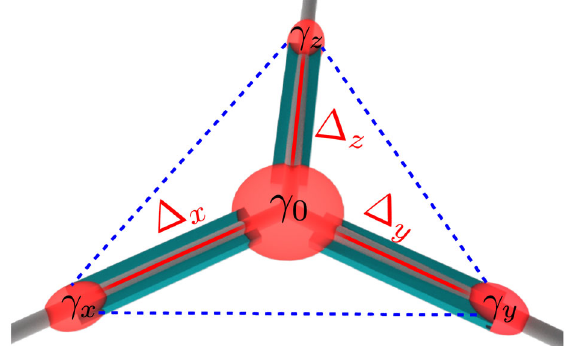
FIG. 1. The Y -junction system. Lines and labels indicate the model Hamiltonian of four coupled Majoranas γ , while the i background shows a possible realization using wires (gray) proximity coupled to s -wave superconductors (green). We assume that couplings at the arms are determined through external imprecise controls. The true couplings are ~ Δ ¼ ~ δ þ ~f ð ~ δ Þ . It is indeed beneficial to think of the coupling to the x , y , and z arms as geometric objects, namely, vectors in a three-dimensional space. In addition to the couplings along the arms, any physical system will also exhibit couplings between the tips (dashed blue lines). These unavoidable couplings introduce a parity-dependent dynamical phase, and, along with the control uncertainty, are leading sources of